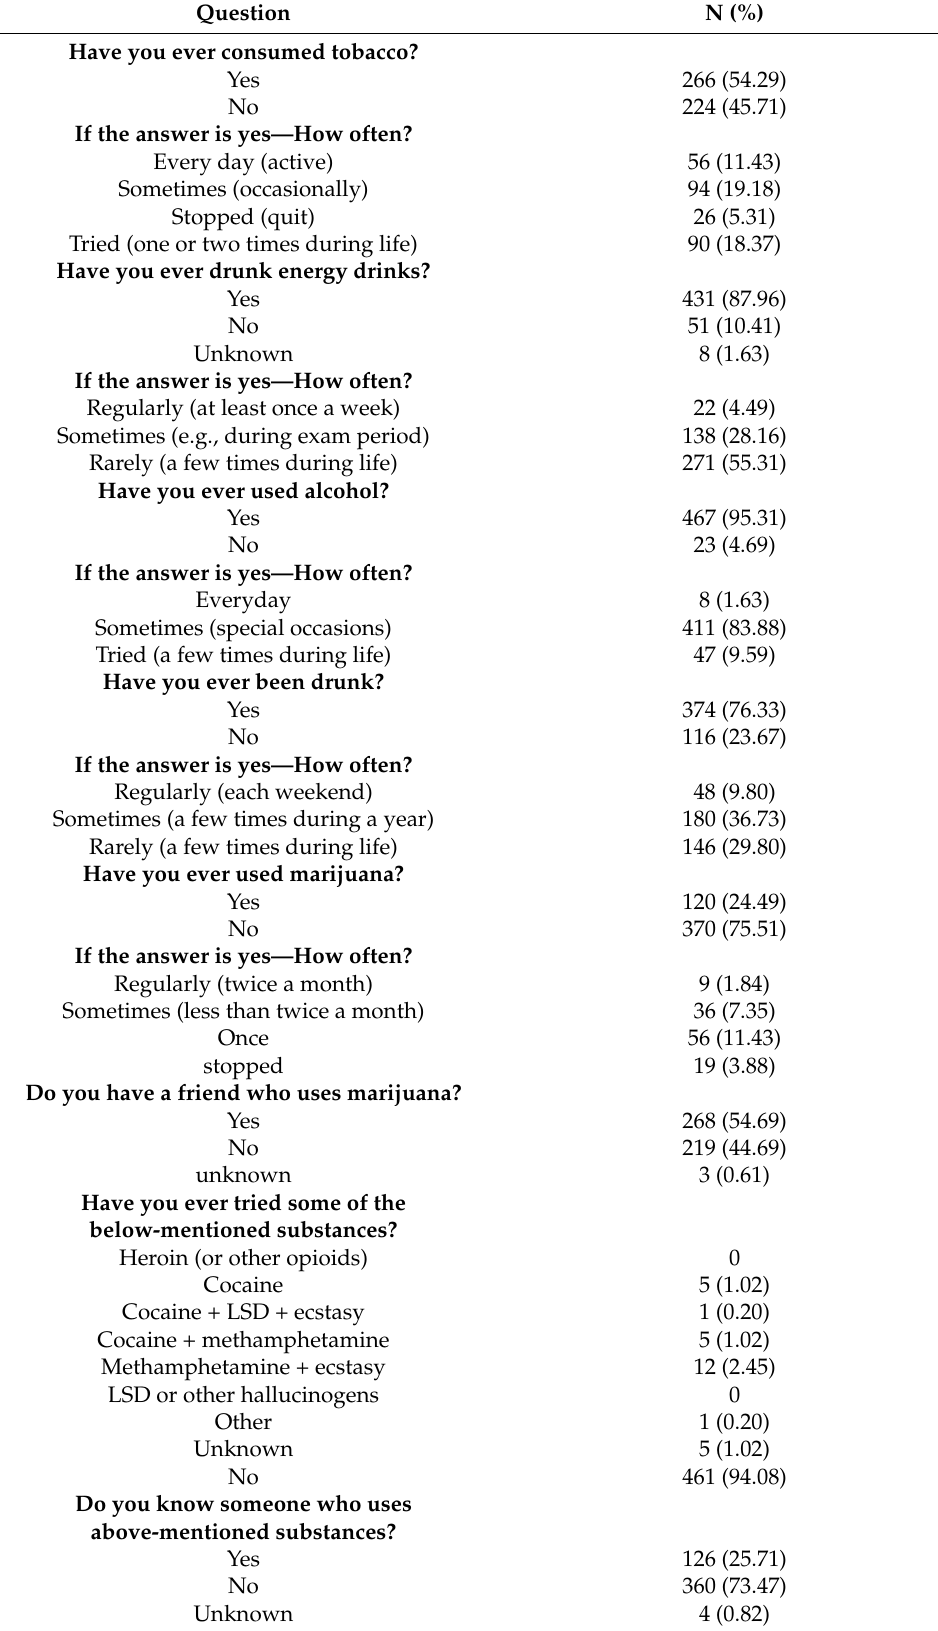
Table 2. Future HCPs’ habits regarding (il)legal psychoactive substances